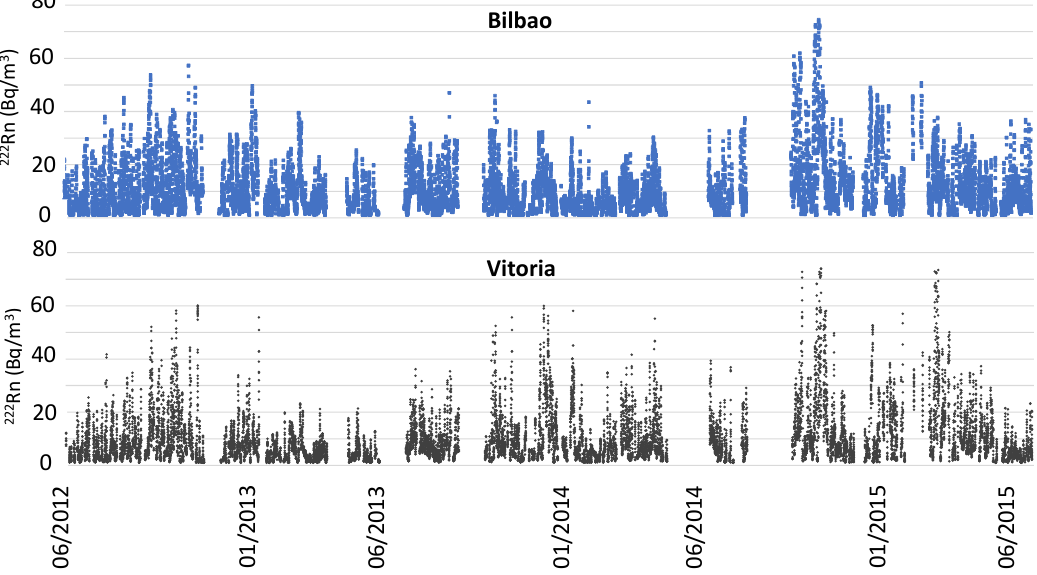
Figure 2. Time series of 222 Rn hourly concentrations in Bilbao and Vitoria during the period from June 2012 to June 2015. Only hourly values of “pairs of days”, i.e., daily concentrations must both be above zero Bq m −3 .